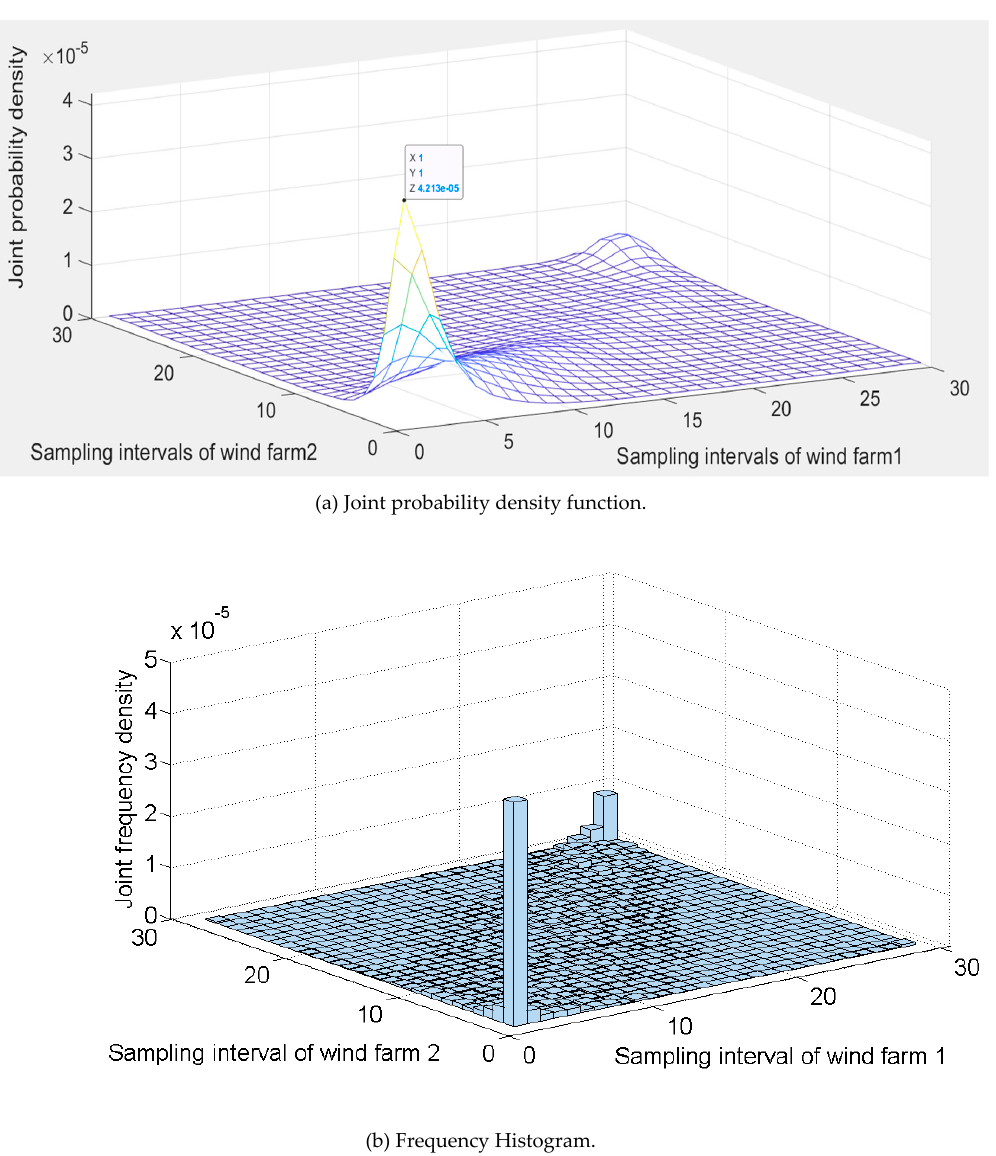
Figure 3. Joint probability density function and frequency histogram of Wind Farms 1 and 2.